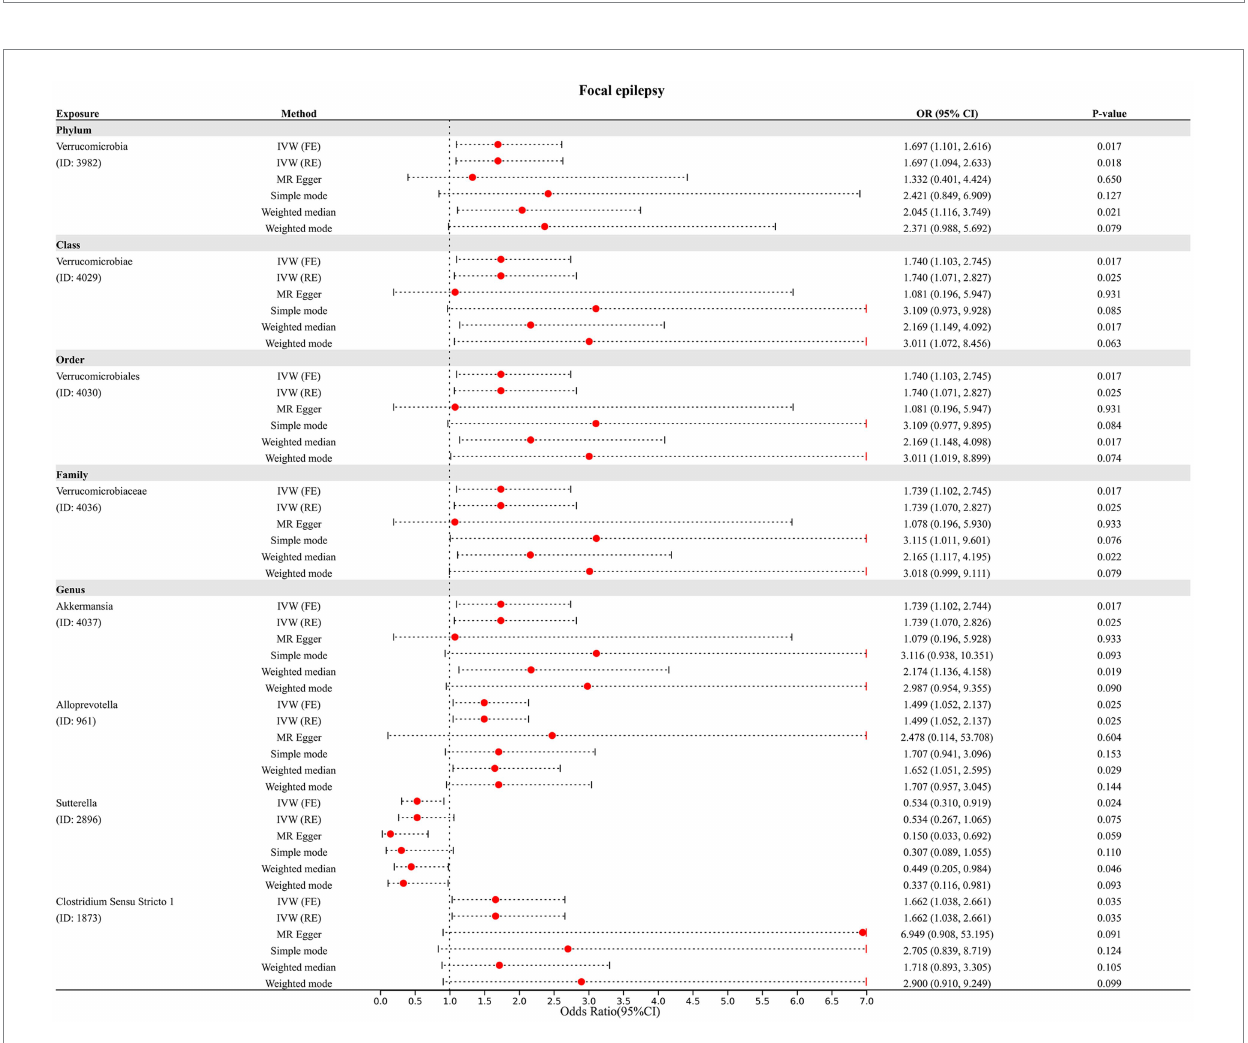
FIGURE 5 Diverse MR results for 8 GM taxa causally associated with focal